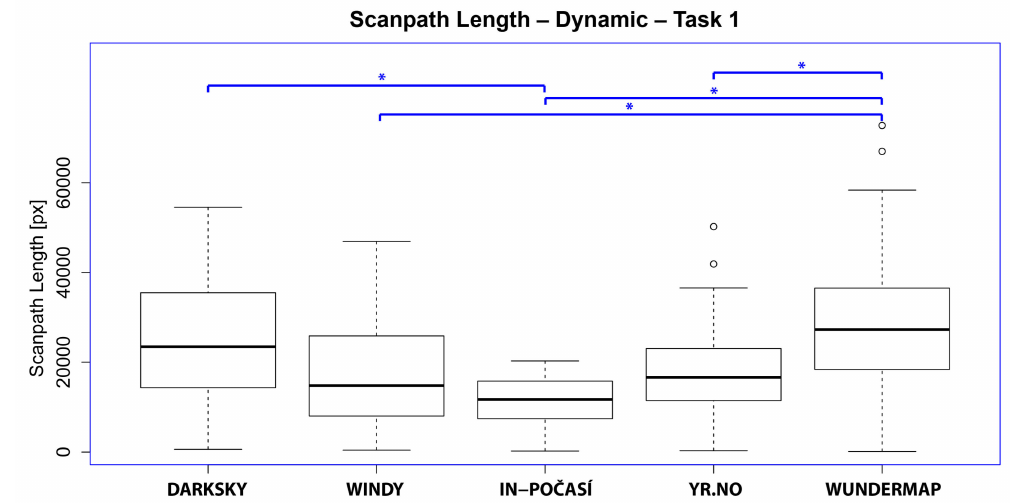
Figure 10. Scanpath Length analysis for the Dynamic Section—Task